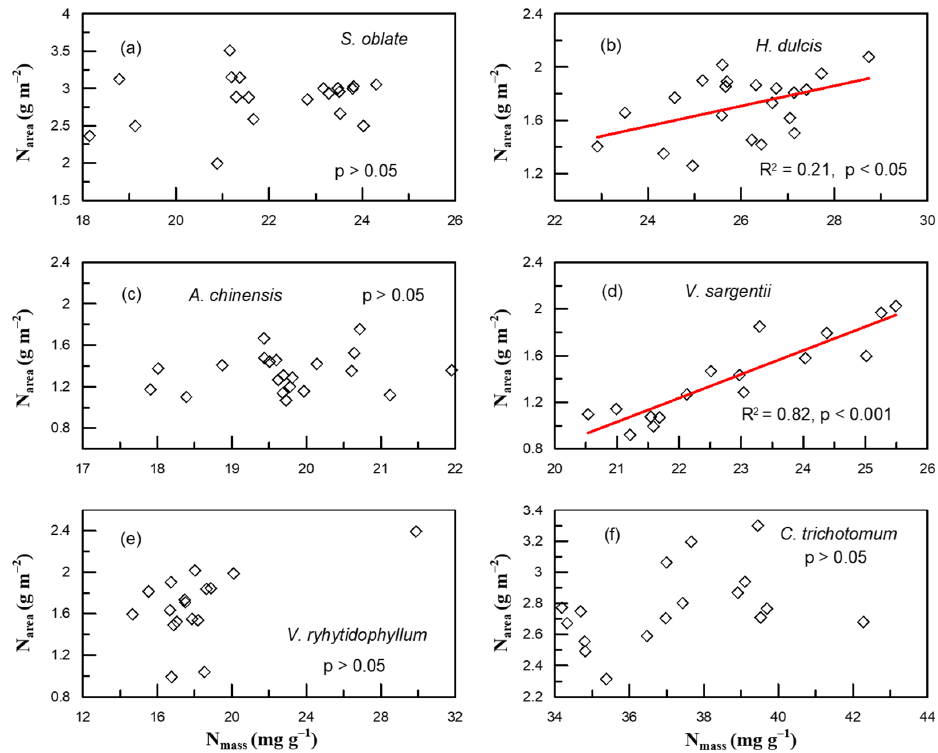
Figure A2. Relationship between leaf N based on area (N area ) and leaf N based on mass (N mass ) of six species derived from the third sampling campaign: ( a ) S. oblate , ( b ) H. dulcis , ( c ) A. chinensis , ( d ) V. sargentii , ( e ) V. rhytidophyllum , ( f ) C. trichotomum